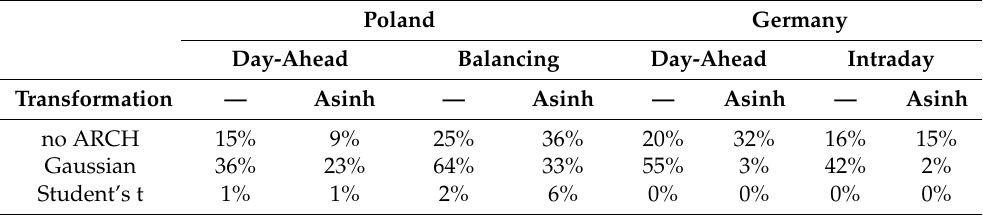
Table 2. Percentage of rejected hypotheses in tests for residuals on: (i) no ARCH effects; (ii) Gaussian distribution; (iii) Student’s t distribution. All tests were performed on a 5% significance level. For transformation denoted by ‘—’, the models were fitted to nontransformed